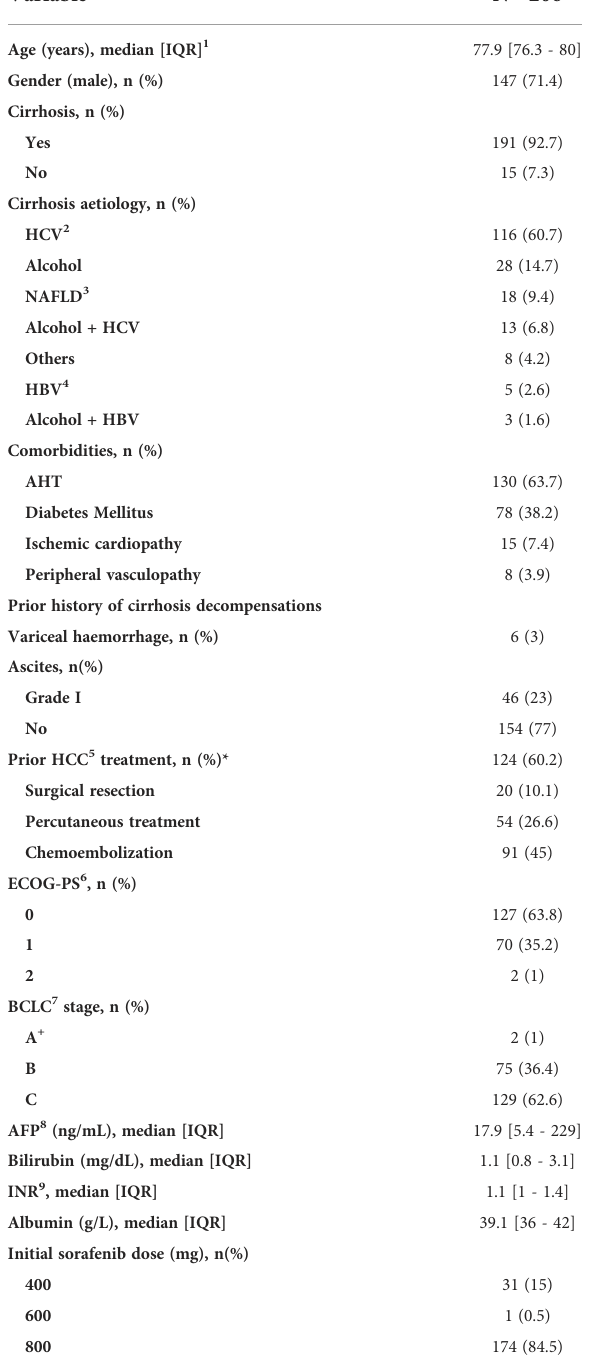
TABLE 1 Patient baseline characteristics at initiation of